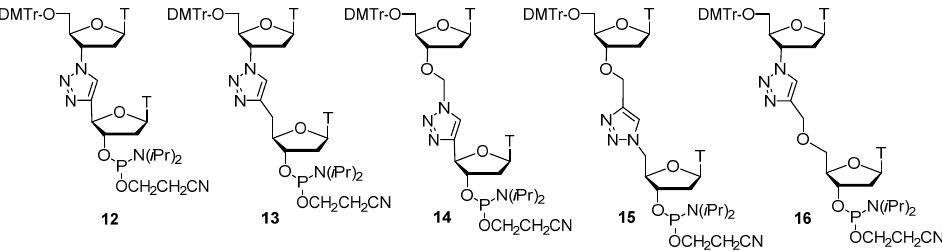
Figure 7. Phosphoramidite triazole-linked dimers T–T.